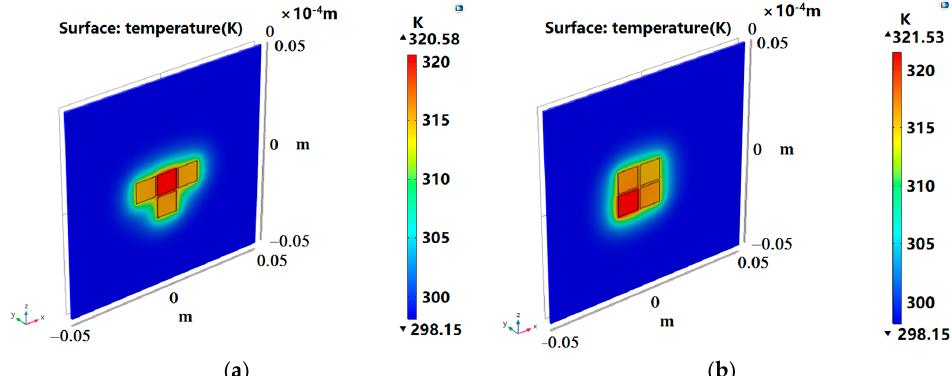
Figure 6. Situation 2: initial layout ( a ) and optimized layout ( b ). Micromachines 2019 , 10 , x